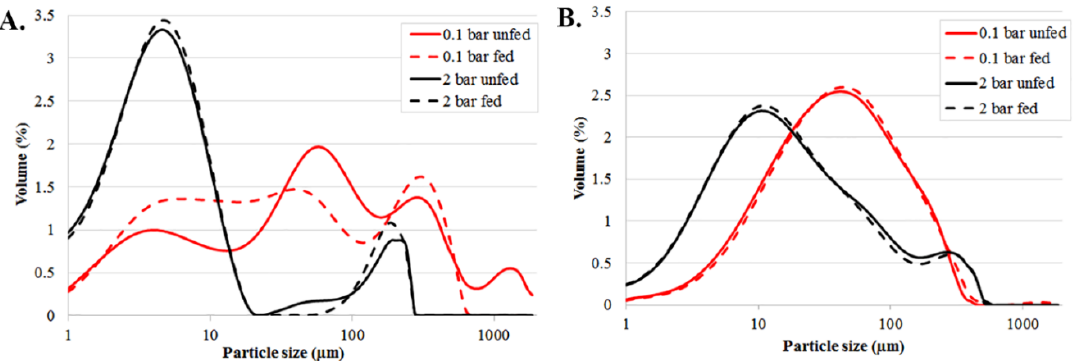
Figure 2. Particle size distribution of ( A ) spironolactone and ( B ) paracetamol .